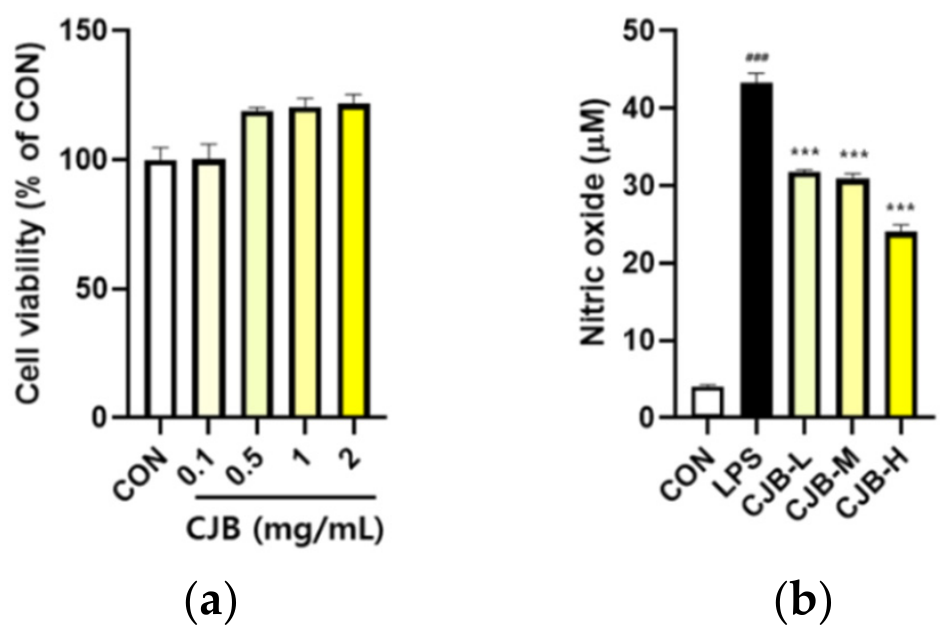
Figure 6. Cell cytotoxicity and production levels of nitric oxide (NO) in LPS-treated mice. ( a ) Cytotoxicity and ( b ) NO concentration. All values are expressed as the mean ± SEM. A p -value under 0.05 was considered statistically significant. ### indicates statistical significance compared to the CON group, and *** indicates statistical significance compared to the LPS group. CON, normal control; LPS, negative control; CJB-L, CJB at 0.5 mg/mL; CJB-M, CJB at 1 mg/mL; CJB-H, CJB at 2